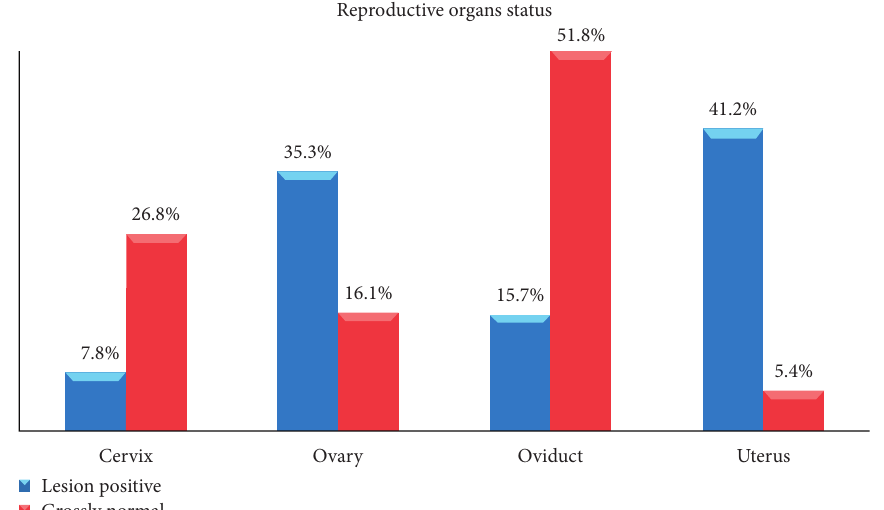
Figure 3: Pathological lesion distribution in reproductive organs of lesion-positive female camels slaughtered at Dire Dawa and Babille municipal abattoirs ( N � 158 Table 2: Identified pathological lesions and their distribution in reproductive organs of female camels. Gross Lesion